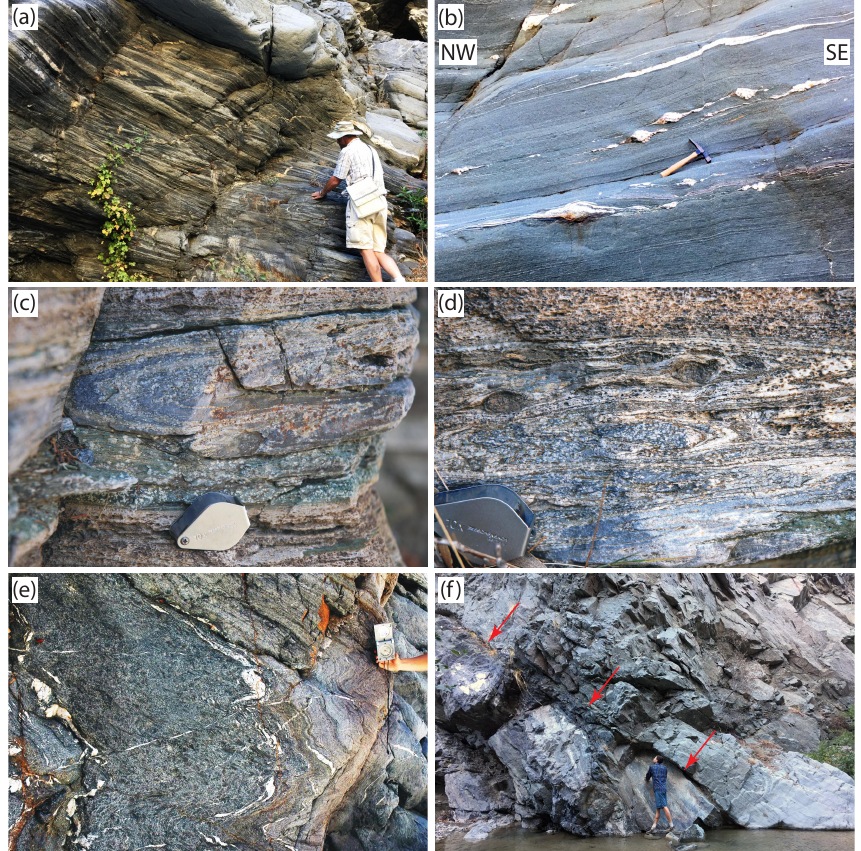
Figure 3. Outcrops of Pelona Schist. Photo locations can be found in Fig. 2a and Table S1. (a) D2 folds in metagreywacke. (b) Mafic greenschist with boudinaged quartz veins. (c) D2 folds in metachert. (d) Sheath folds in metachert and mafic greenschist. (e) Minor D3 folds near the hinge of the Narrows synform. (f) Vincent Fault as shown by the arrows; viewing SE.